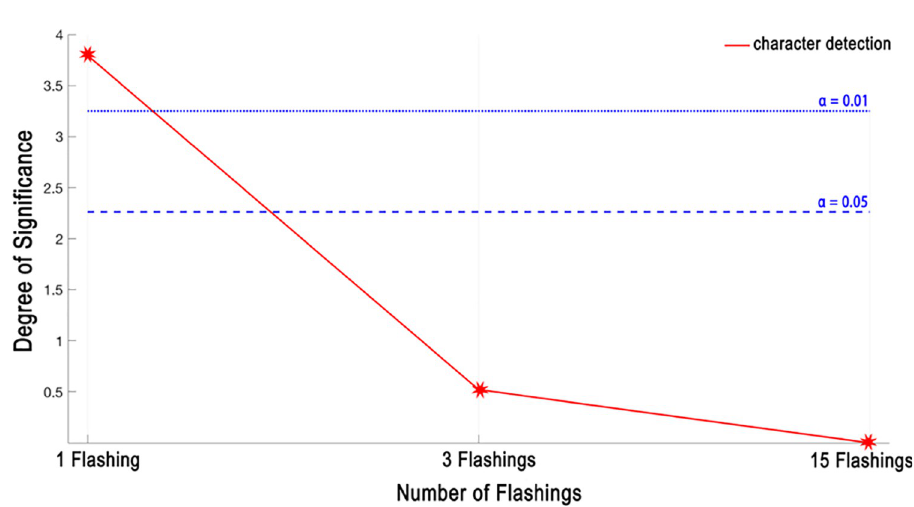
Fig 16. Degree of significance results in character